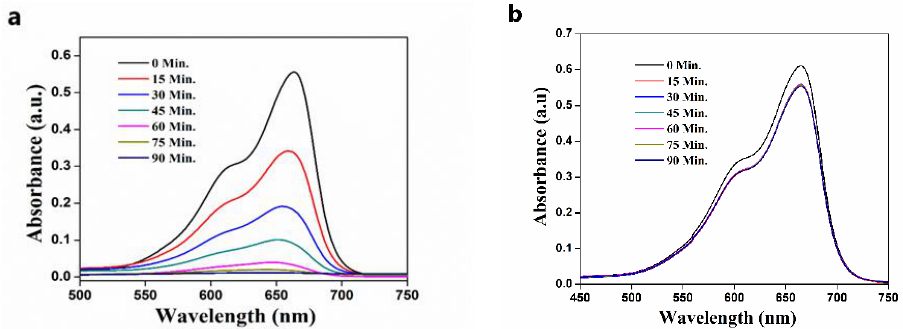
the absence of sunlight. Figure 9. The photo-degradability of MB dye by ZnO catalyst ( a ) in the presence of sunlight; ( b ) in